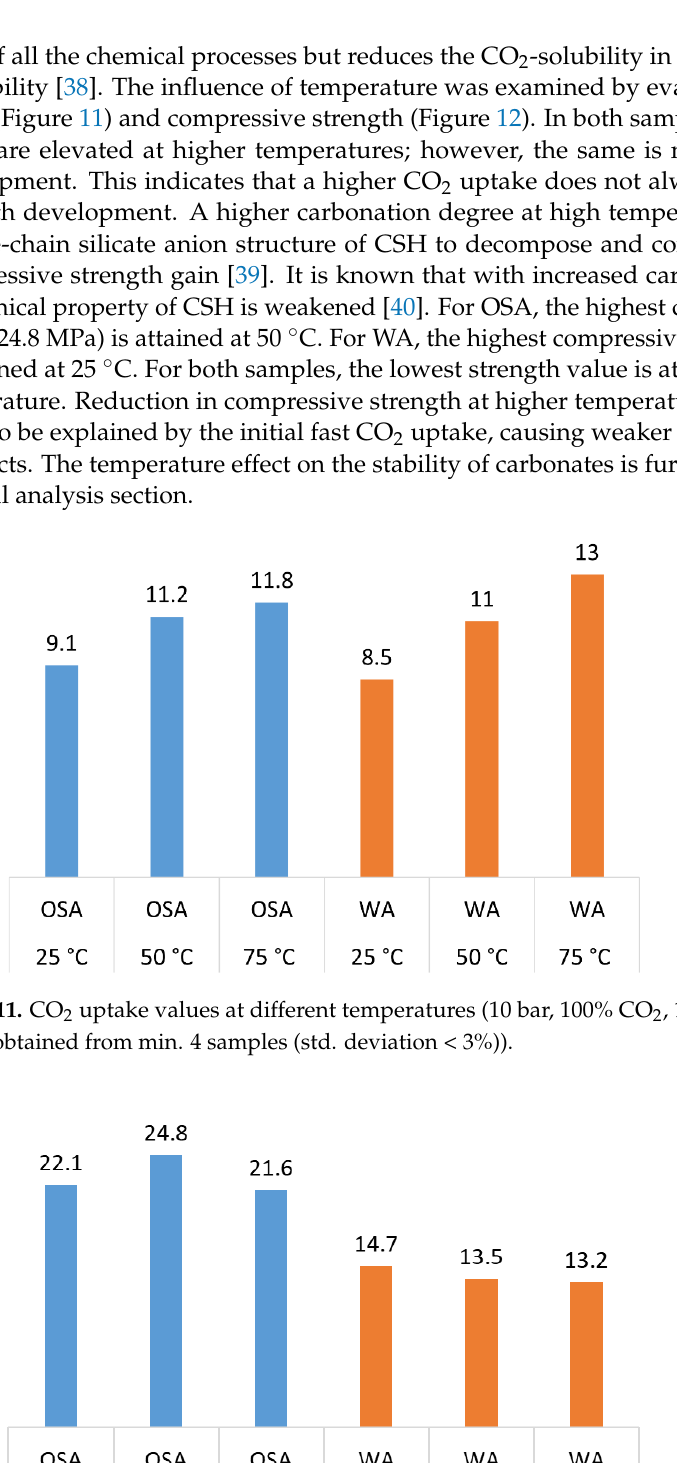
Figure 10. CO 2 uptake ( left ) and compressive strength ( right ) values at different CO 2 concentrations (10 bar, 25 °C, 150 kgf/cm 2 ) (Average values obtained from min. 4 samples (std. deviation < 3%)).